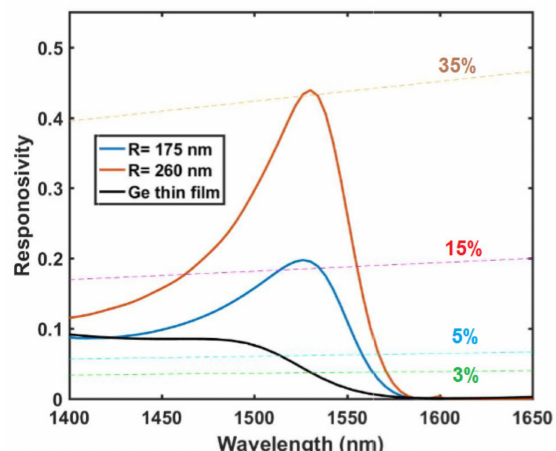
Figure 4. Normalized responsivity as a function of the incident light wavelength for the two devices of R = 175 nm ( H = 275 nm) and R = 260 nm ( H = 205 nm) and for 275 nm-thick Ge film. Dashed lines show the various quantum efficiencies across the whole wavelength range (i.e., Responsivity = η q λ / hc where η = 0.03, 0.05, 0.15, and